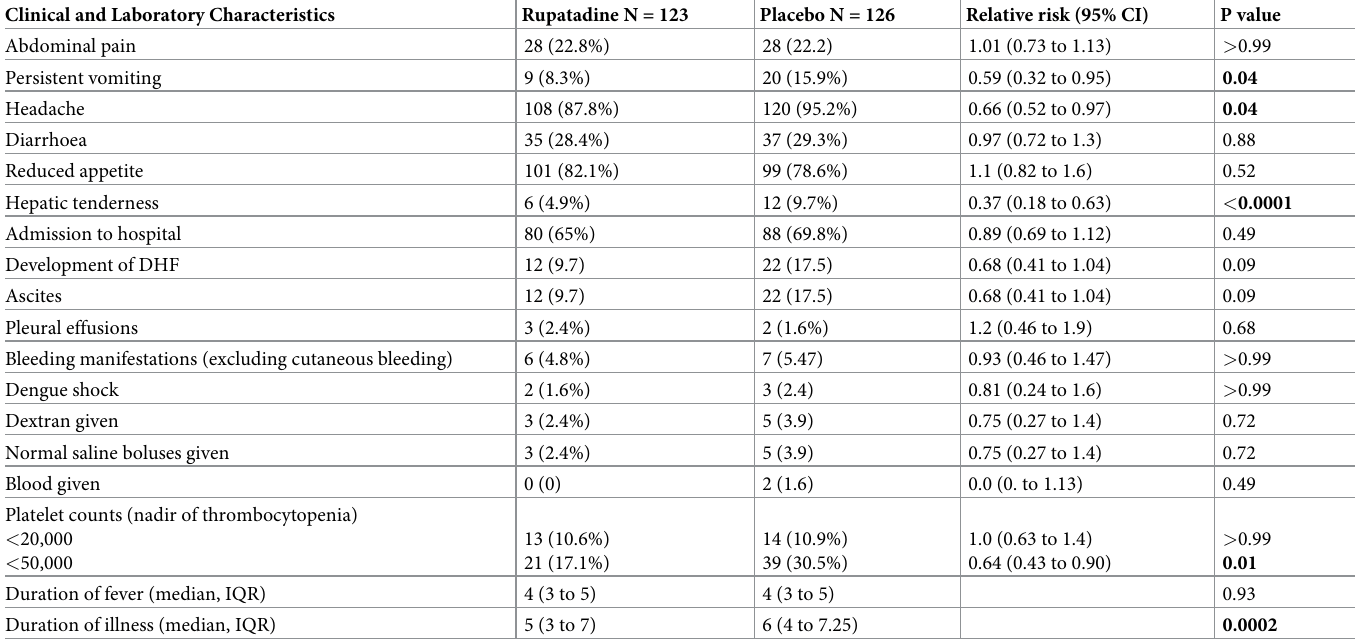
Table 2. Clinical and laboratory features in those who were given rupatadine 40mg for 5 days or a placebo for 5 days. Clinical and Laboratory